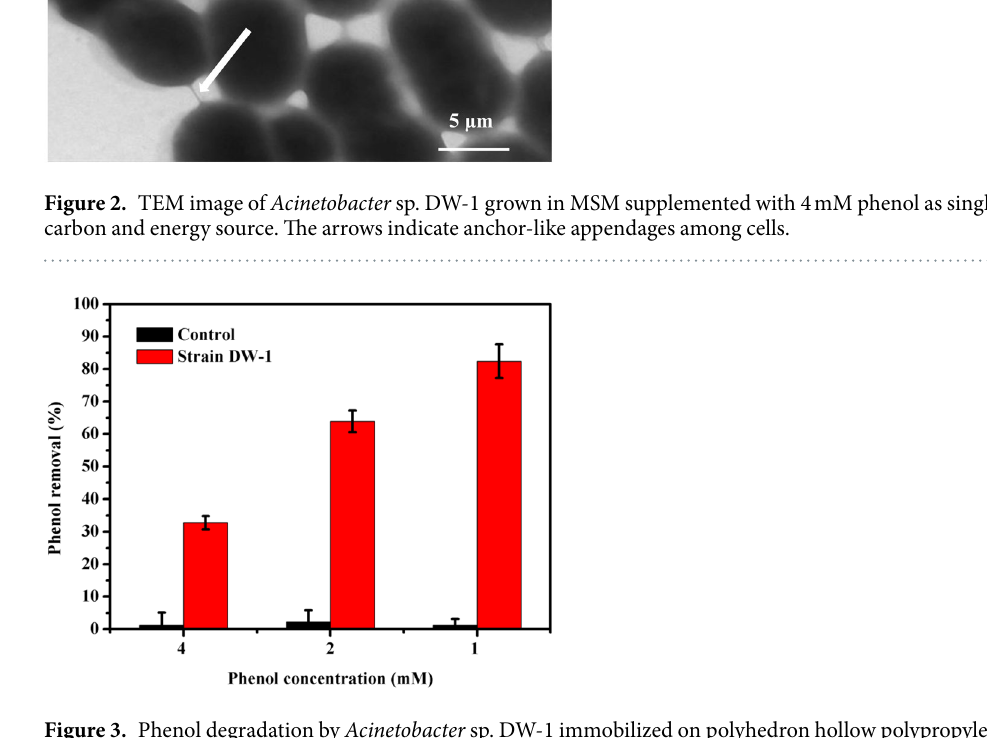
Figure 3. Phenol degradation by Acinetobacter sp. DW-1 immobilized on polyhedron hollow polypropylene balls.